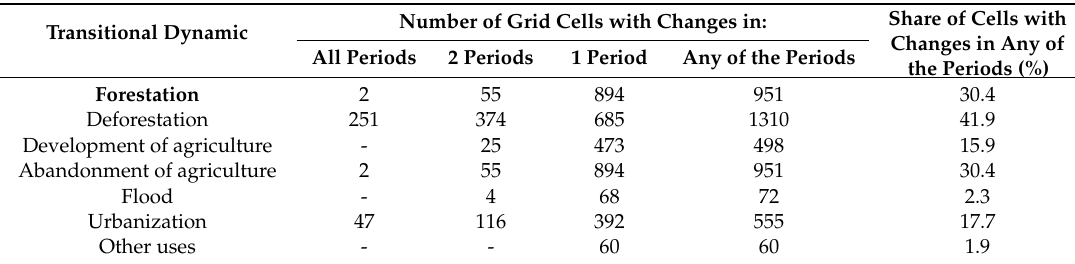
Table 4. Cells with changes by transitional dynamics.